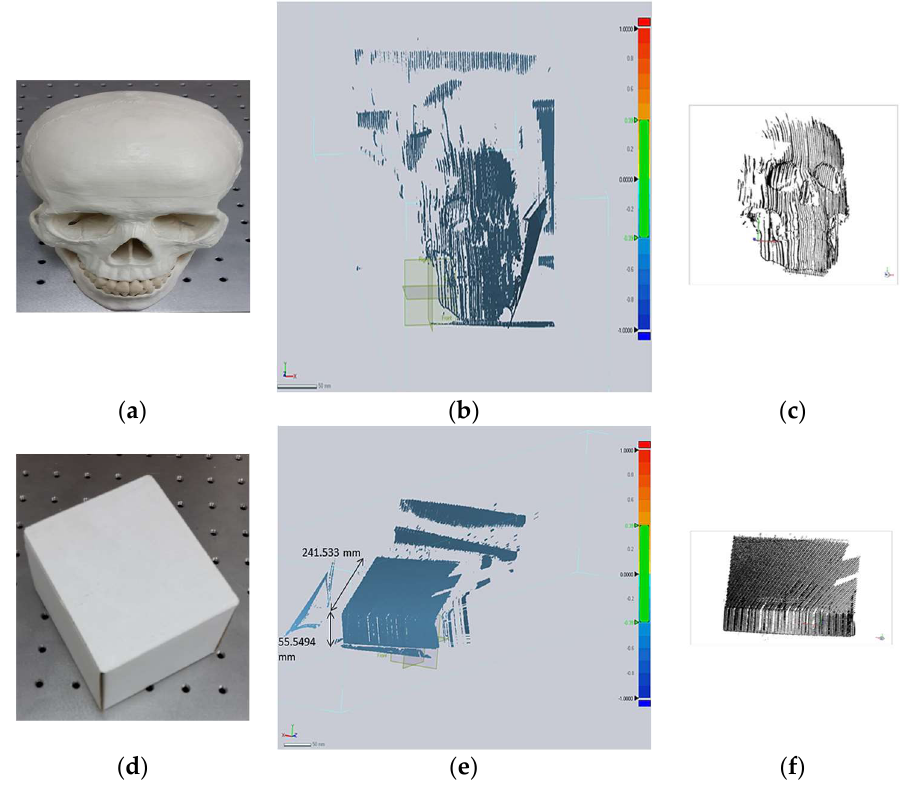
Figure 5. Results of the 3D reconstruction, ( a – c ) Qualitative analysis of the 3D reconstruction showing the actual skull object, and the preservation of the features of the skull before and after post processing, ( d – f ) Quantitative analysis of the 3D reconstruction showing the actual box object, its measured height and length and the result of the 3D reconstruction before and after the post processing.